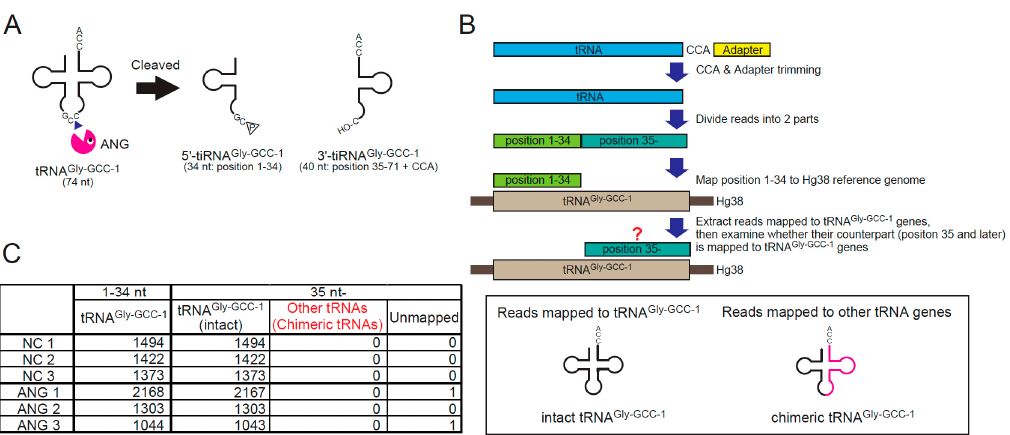
Figure 3. Chimeric tRNAs are not detected in cellulo . ( A ) ANG-mediated cleavage site in tRNA Gly-GCC-1 . ANG cleaves between C and C in the anticodon of tRNA Gly-GCC-1 , generating 34-nt 5 ′ -tiRNA Gly-GCC-1 and 40-nt 3 ′ -tiRNA Gly-GCC-1 . ( B ) Flowchart of the analysis to detect chimeric tRNAs comprising 5 ′ -tRNA Gly-GCC-1 . For the detail, see Materials and Methods. ( C ) ANG treatment does not induce chimeric tRNA production in the cell.